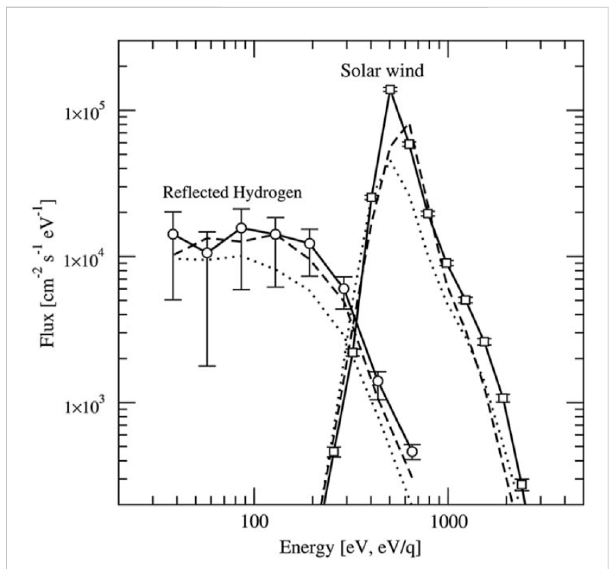
FIGURE 10 Typical energy spectra of the pristine solar wind ions (right side, open squares) and of the corresponding energetic neutral hydrogen atoms, produced by re fl ection of the solar wind ions at the lunar regolith (left side, open circles). Spectra measured by the SARA instrument onboard the Chandrayaan-1 spacecraft. (From: Wieser et al., 2009).